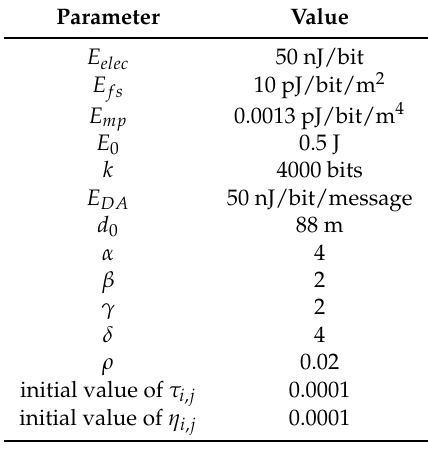
Table 1. Radio characteristics used in our simulations.